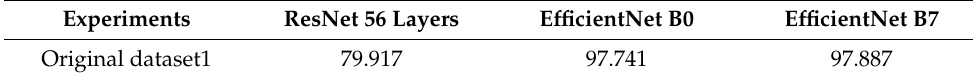
Table 3. Experimental accuracy (%) on dataset